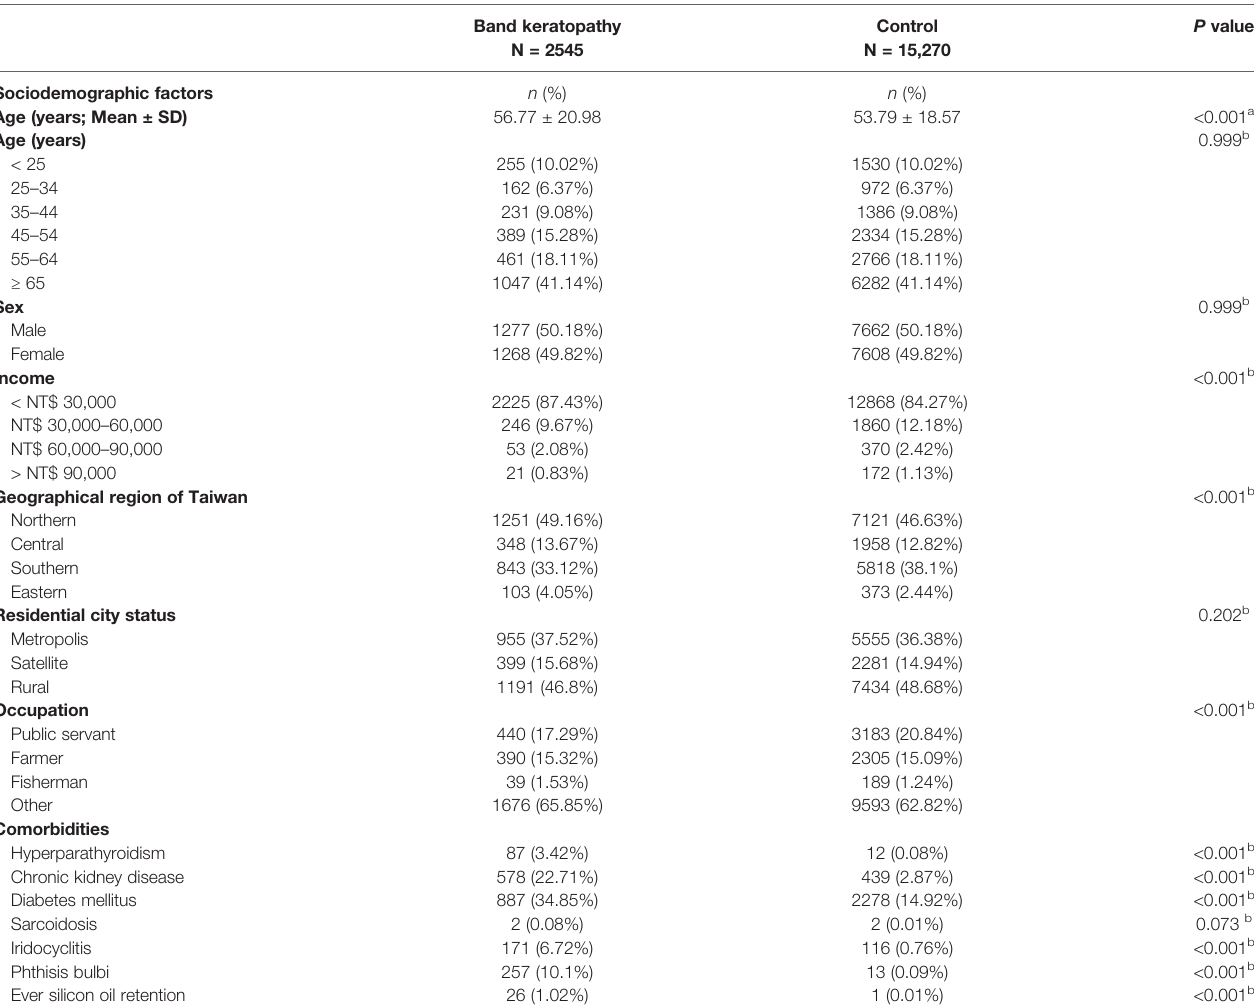
TABLE 1 | Baseline sociodemographic factors and comorbidities in patients with band keratopathy and controls after matching by age and